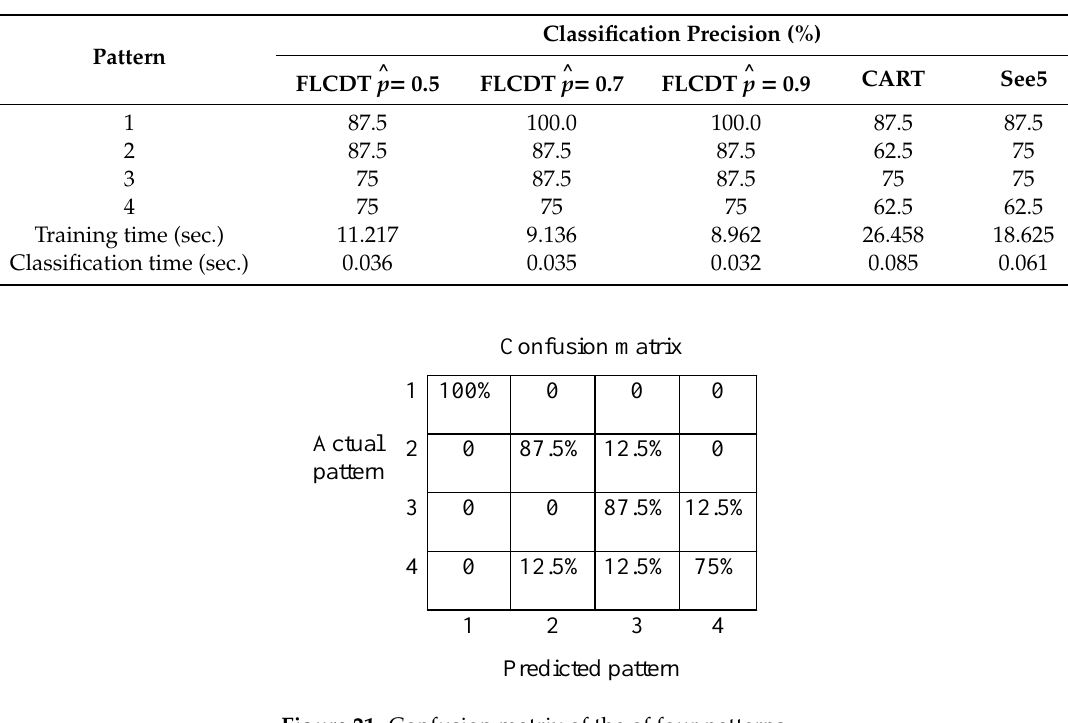
Table 3. Test results.